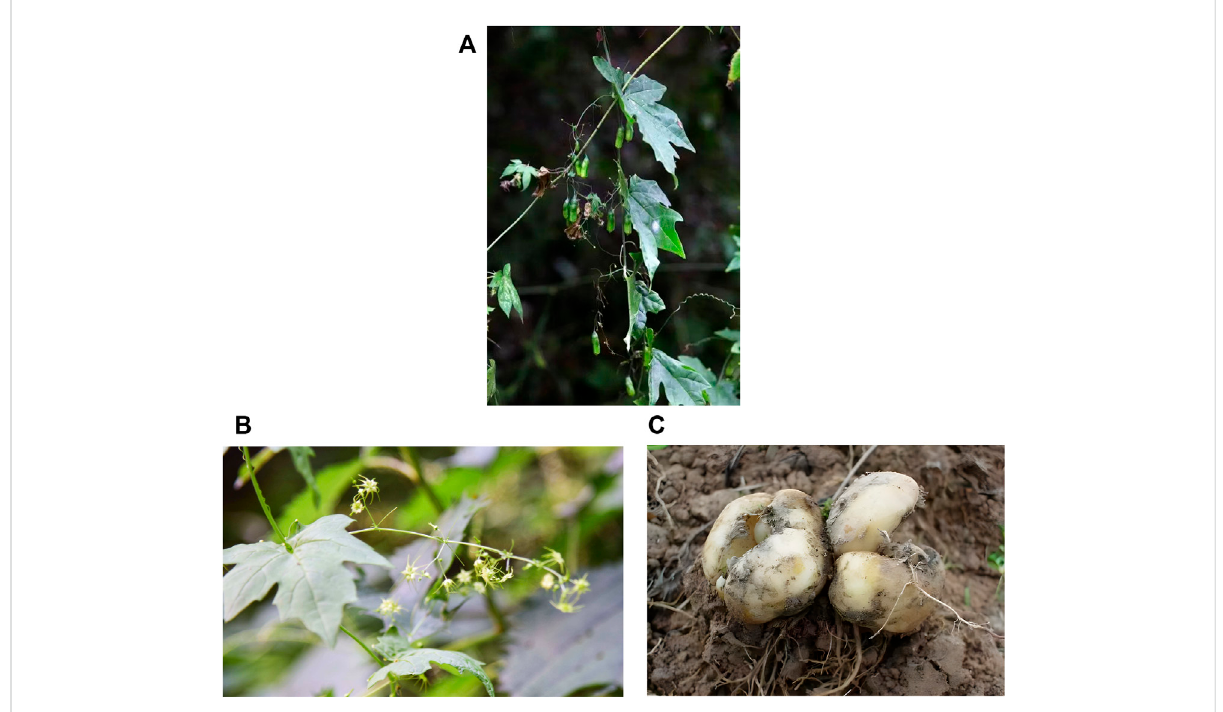
FIGURE 1 Bolbostemma paniculatum (Maxim.) Franquet: (A) Aboveground part, (B) fl owers, and (C) stem